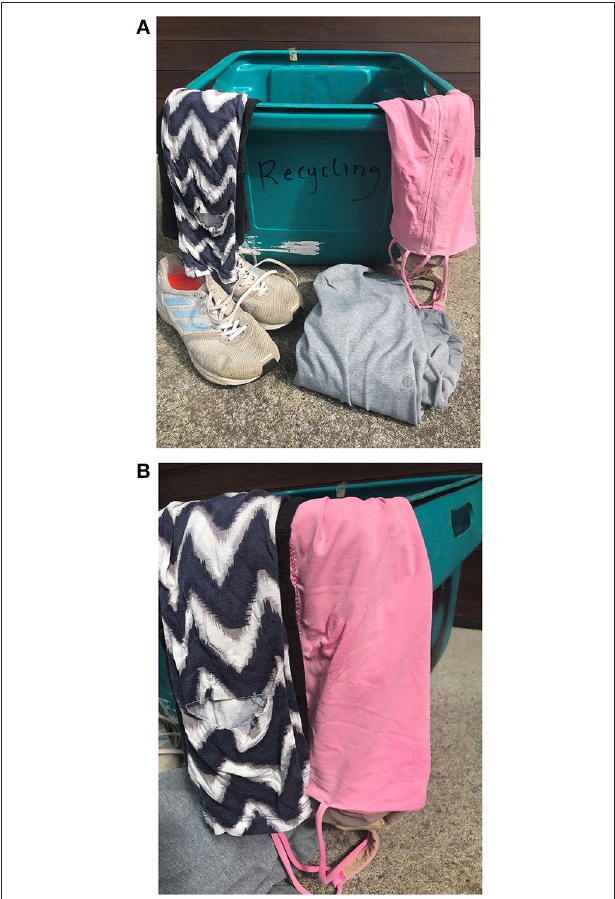
FIGURE 3 | (A,B) Images of discarded activewear with holes, faded colors, and